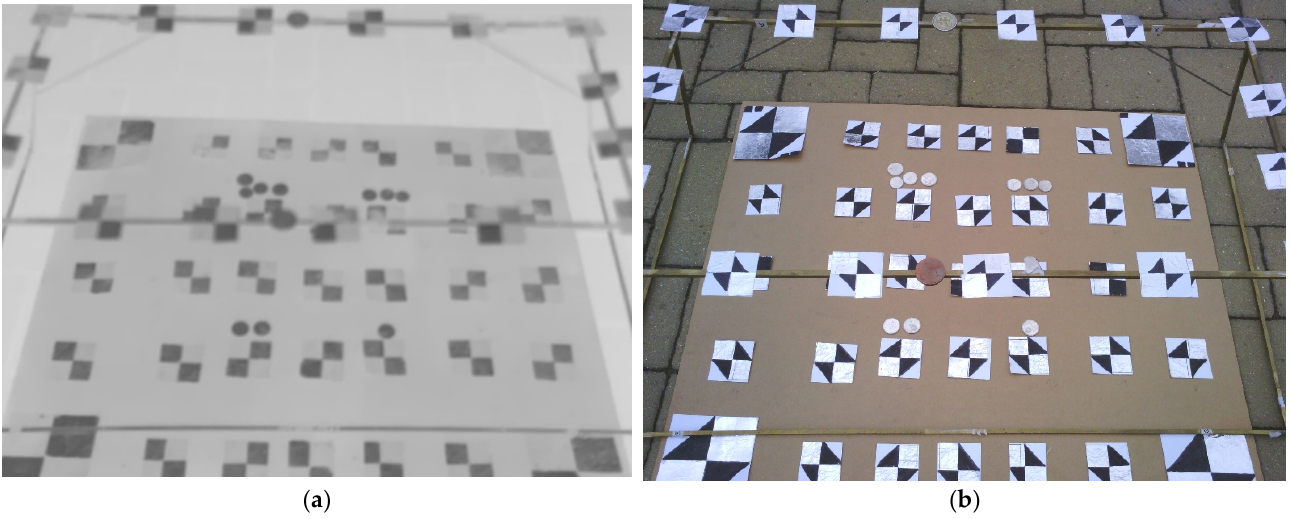
Figure 7. Images for camera calibration using the 2-level calibration field: ( a ) TIR image; ( b ) RGB image. As a second calibration field, a 3-level calibration field was created (see Figure 8), on the same principle as the 2-level calibration field created. The approximate dimension of the 3-level calibration field was 1200 × 800 × 73 mm. The reason for creating the 3-level calibration field was to test if there was improvement in terms of accuracy, and if there was more 3D structure on the calibration field. The base was a plane desk, where the same targets were placed, similar to the 2-level calibration field. Over the desk, a first construction frame was placed, and then over the first construction frame, the second construction frame was placed. On both frames, targets were placed. Targets were measured by total stations and 12 distances were measured by a measuring tape. Both spatial calibration fields were homemade creations. Again, the accuracy of the coordinates of the measured targets was determined as 3 mm and the accuracy of the measured distance was determined as 1 mm.